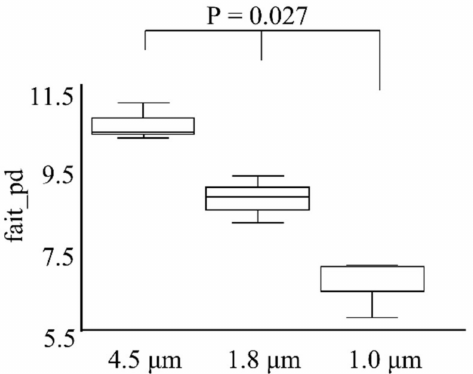
Figure 6. Boxplot of α -diversity indices, which reflect abundance and consistency, of microflora obtained from the MMDs at low- and high-flow rates. Boxes represent the interquartile range (IQR) between the first and third quartiles (25th and 75th percentiles, respectively), and the horizontal line inside each box represents the median. Whiskers represent the lowest and highest values within 1.5 times the IQR from the first and third quartiles, respectively. Diversity decreased significantly as MMD pore size decreased MMD. P-values were determined by Student’s t -tests. Table 4. The top 10 bacterial isolates identified from air samples collected by MMDs installed in the air suction device. Content rates are mean values ( n = 3) of each OTU read number for the total NGS